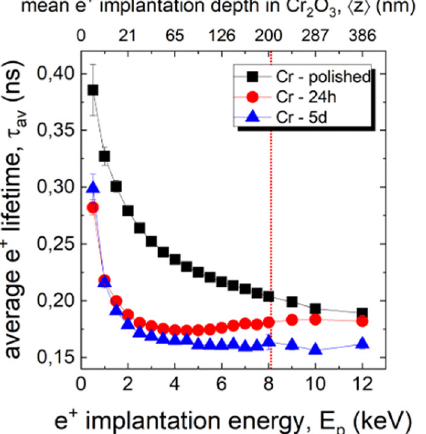
Fig. 5 Average positron lifetime τ av for as-polished chromium versus thermally oxidized chromium. The red line indicates the average oxide thickness for the 24 h annealed sample. Average lifetimes and standard errors were calculated using PALS fi t spectra decomposition 47